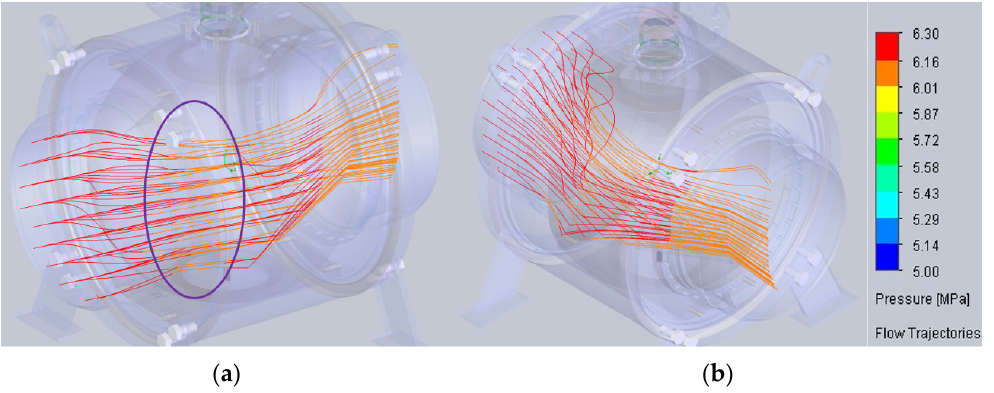
Figure 4. Pressure line trajectories for a 30° closure angle: ( a ) upstream view; ( b ) downstream view.